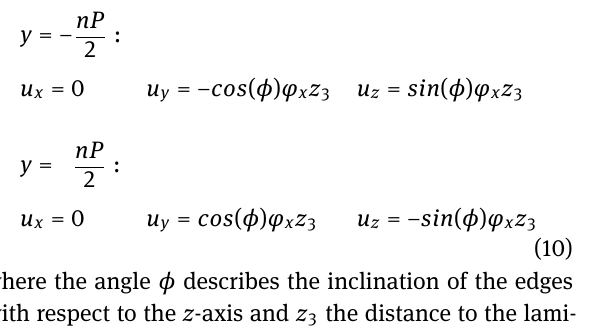
^ κ = nP along x at the clamps: x y 2